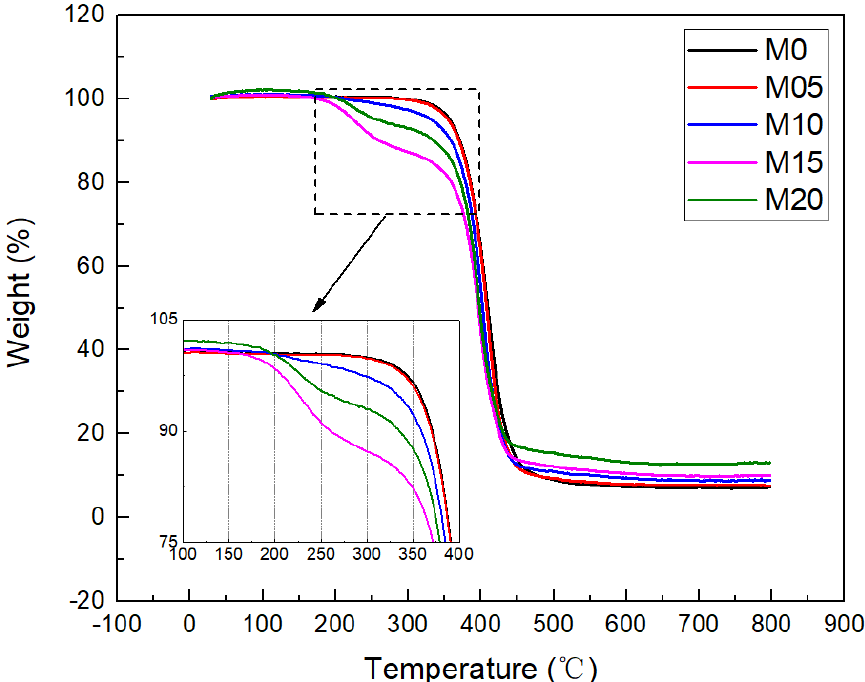
Figure 14. TG curves of phenolic modified epoxy.